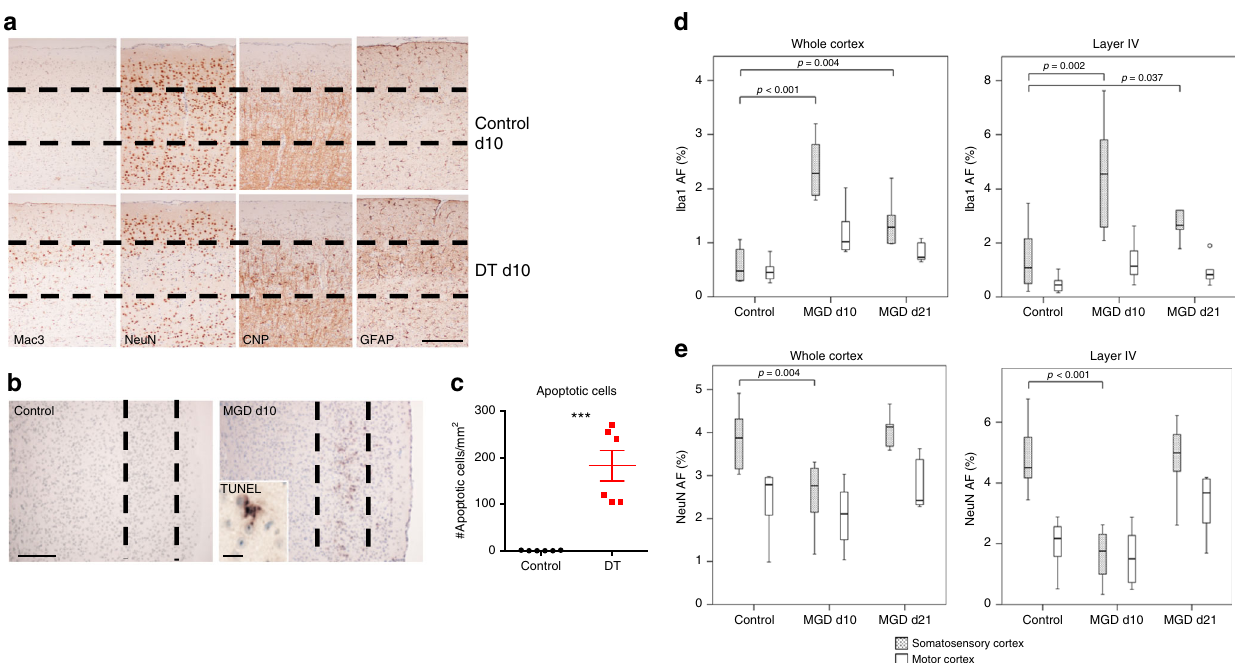
Fig. 2 Degeneration of layer IV somatosensory neurons after microglia ablation. a Representative immunohistochemistry staining for Mac3, NeuN, CNP and GFAP in the somatosensory cortex in control and d10 post depletion mice. Microglia-depleted animals show increased numbers of Mac3- and GFAP- positive cells, but decreased numbers of NeuN-reactive cells. Dashed lines outline layer IV and scale bar = 100 μ m. b TUNEL staining in the somatosensory cortex in control and d10 post depletion animals. Dashed line outlines layer IV, scale bar = 100 μ m and 10 μ m for cropped TUNEL image. c Dot plot depicts quanti fi cation of number of apoptotic cells per mm 2 in layer IV somatosensory cortex of d10 post depletion mice (red) and littermate controls (black).